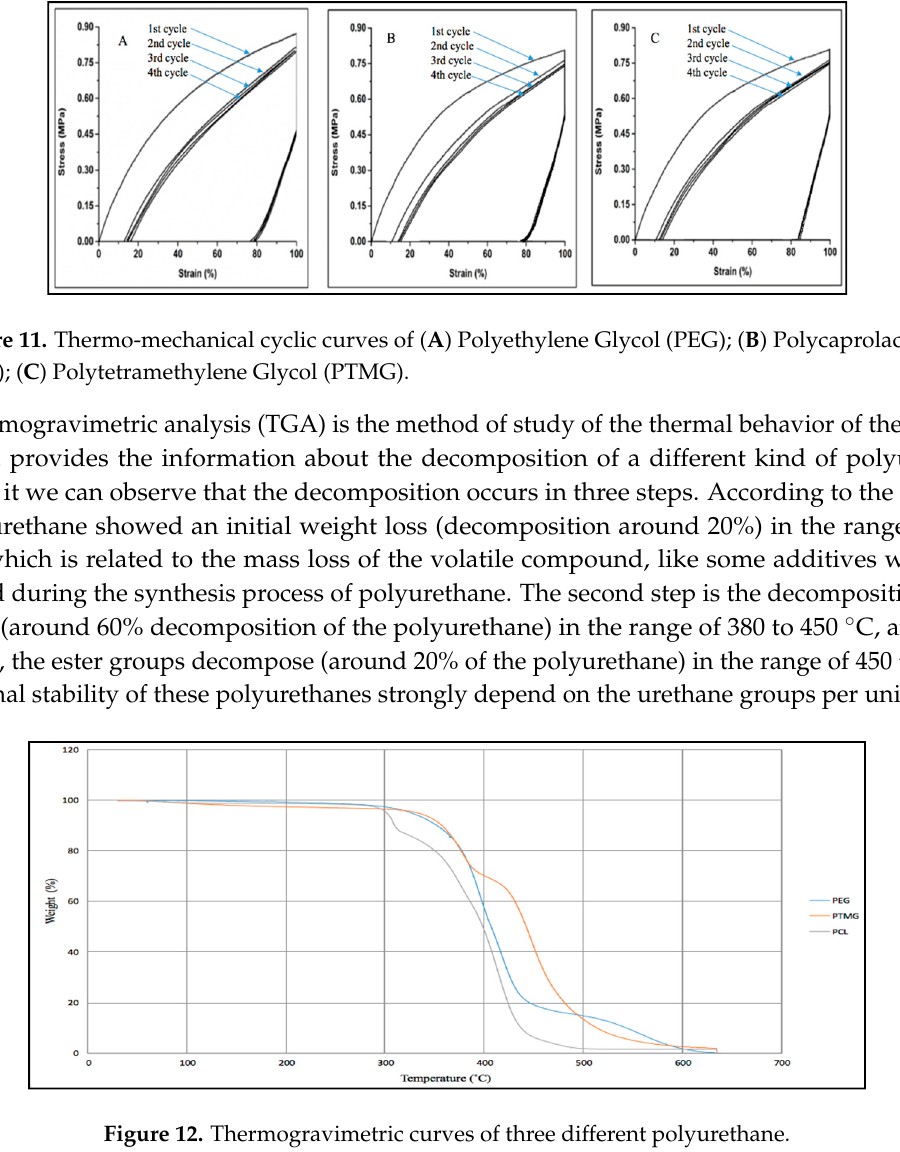
Figure 12. Thermogravimetric curves of three different polyurethane.